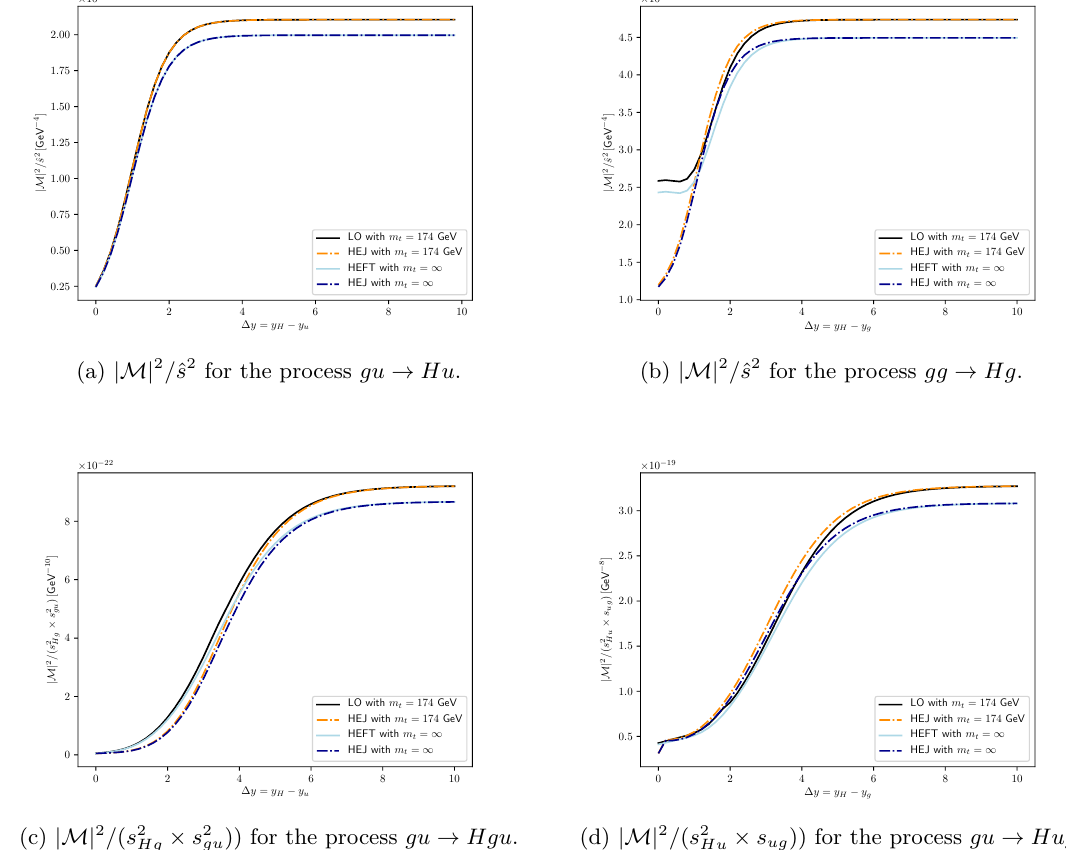
Figure 3. Verifying Regge scaling of the squared matrix elements (equation (2.2)) for 4 different processes. Increasing values of ∆ y on the x -axis approach the MRK limit (equation